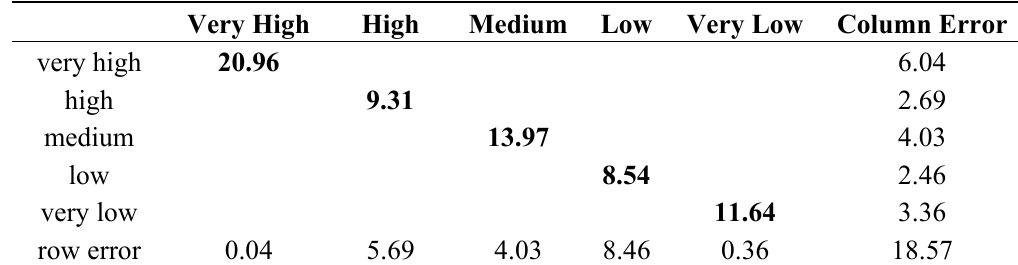
Table 7. Expected number of correct classifiers and total error margins in the Vea study area.